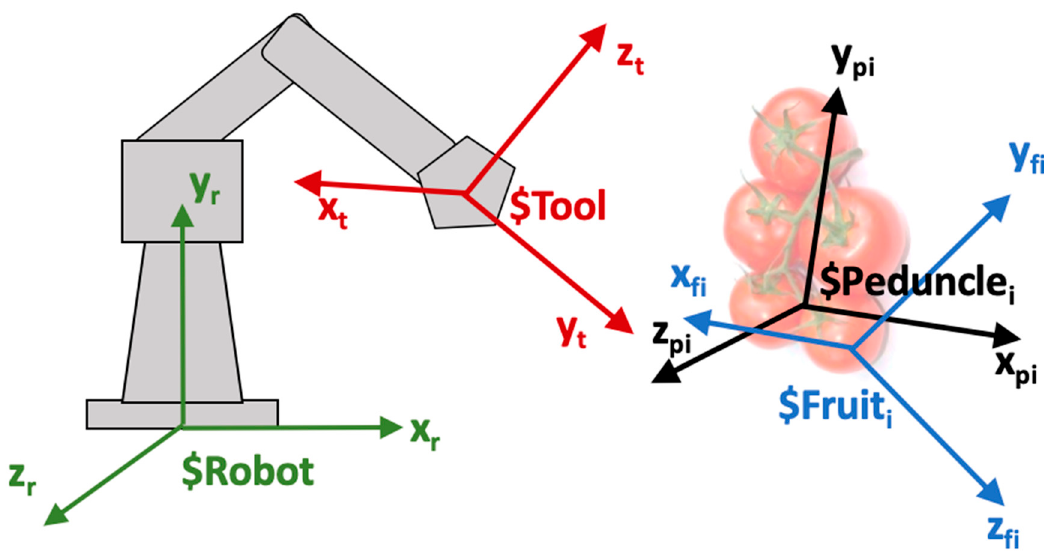
Figure 1. Fundamentals of robot harvesting.